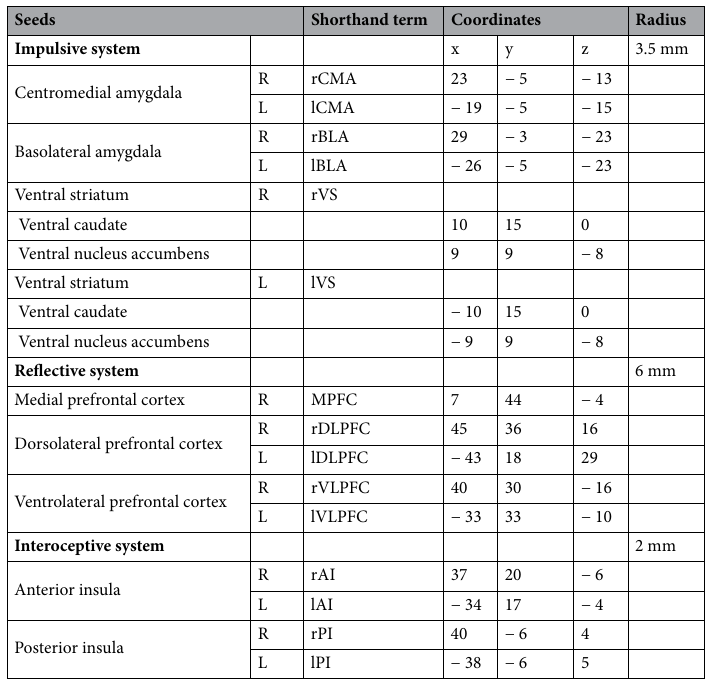
Table 4. Coordinates and radius for each selected seed. Coordinates (x, y, z) are given in Montreal Neurological Institute atlas space